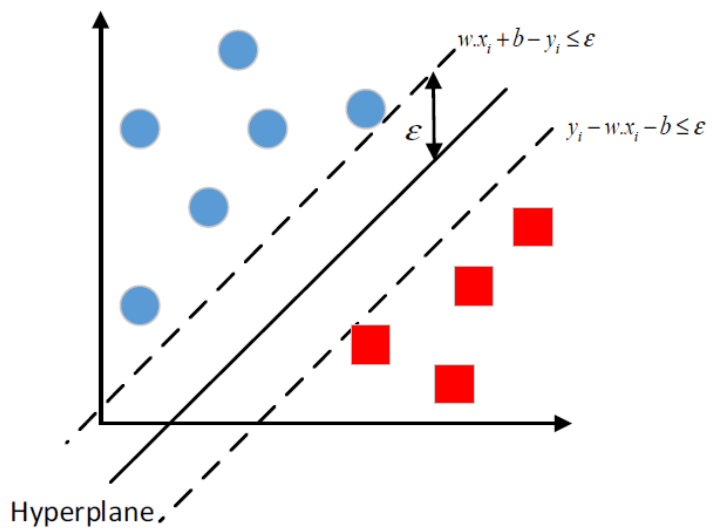
Figure 2. A support vector regression model [42].